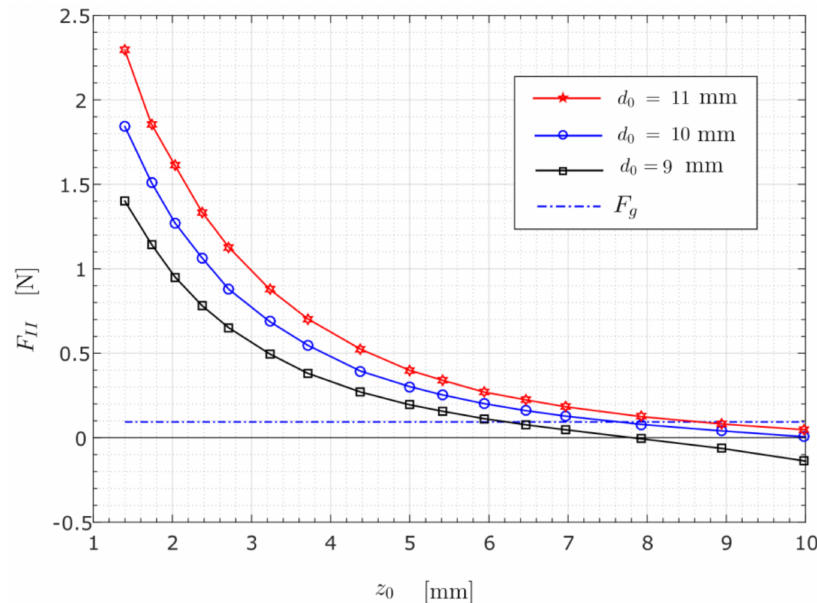
Figure 20. The calculated curves of magnetic levitation force F II for three different values of the PM’s diameter, i.e., d 0 = 9 mm, d 0 = 10 mm, and d 0 = 11 mm, respectively. The force F II was calculated by the SIM. The stable levitation height z 0 appears where the individual curve F II in-tersects the gravitational force line F g . In calculations, the PM’s volume remained unchanged.